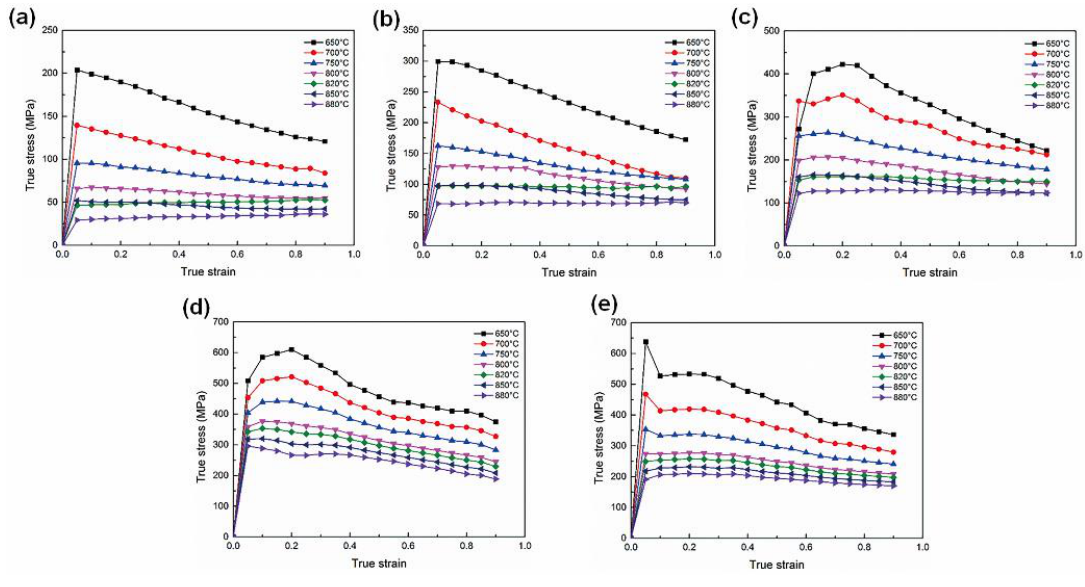
Figure 2. True stress–strain curves of TB18 alloy at ( a ) 0.001 s − 1 , ( b ) 0.01 s − 1 , ( c ) 0.1 s − 1 , ( d ) 1 s − 1 , ( e ) 10 s − 1 .